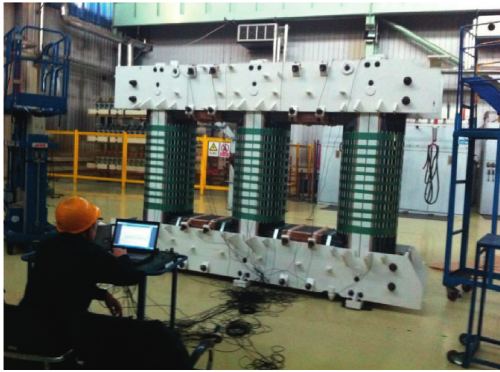
Figure 16: Modal test site of the transformer core. Table 2: Modal test results of the transformer